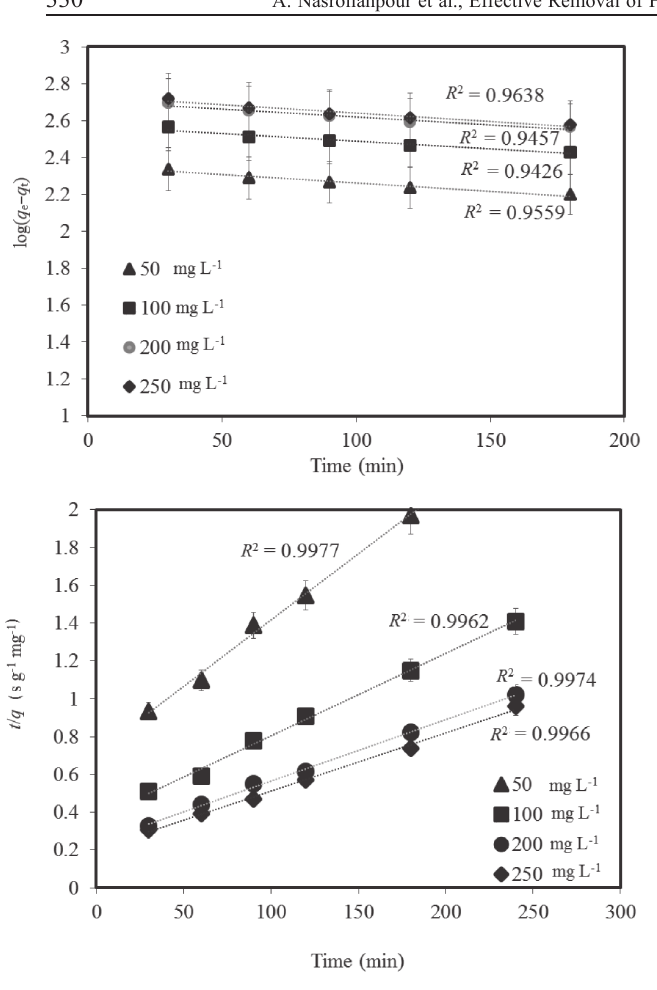
Fig. 9 – Kinetic equations (pseudo first order and pseudo second order) for chromate removal by IL-rGO sorbent at dif- ferent concentrations (agitation speed = 250 rpm, sorbent dos- age = 0.5 g L –1 , room temperature = 298 K, pH 4.0)